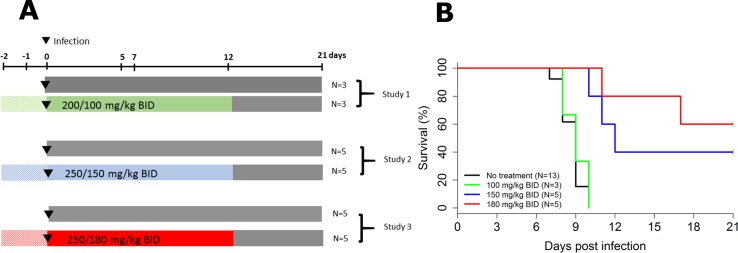
Survival according to the dosing group.(A) Study design; (B) survival curves.